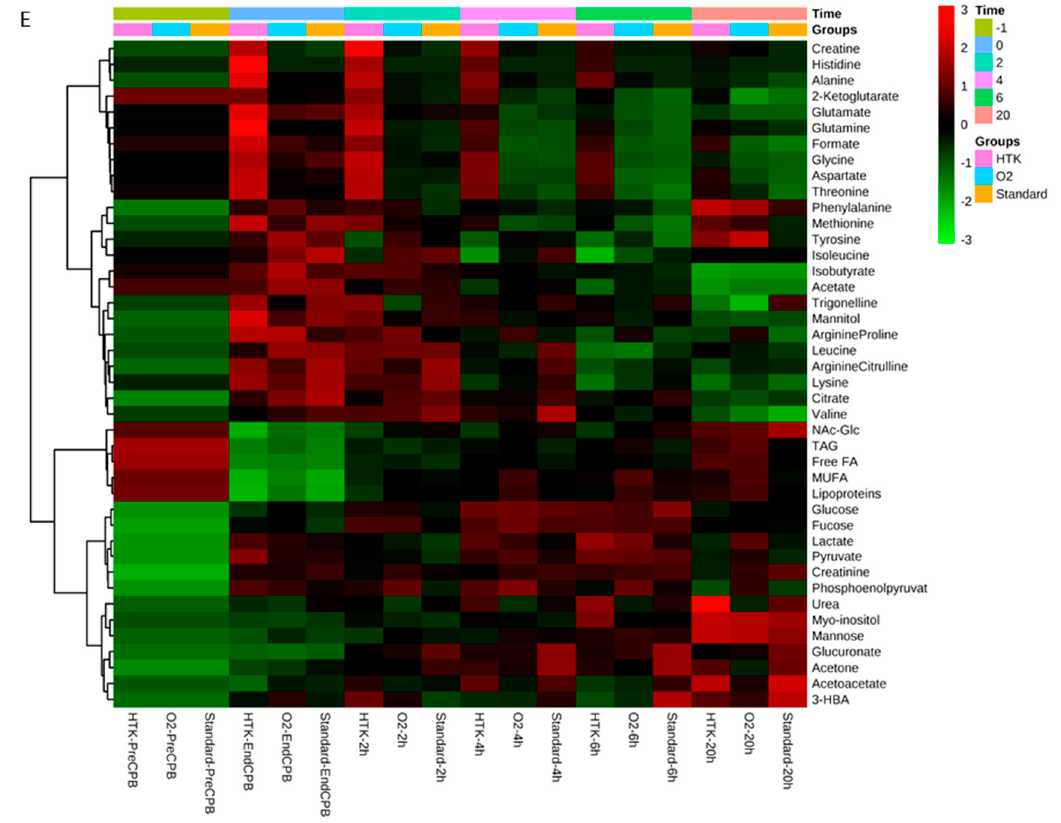
Figure 3. Metabolome changes as a consequence of the surgical procedure and lung protection regimen received. ( A ) Principal component analysis (PCA) scores plot containing NMR spectral data of plasma collected before CPB (blue), at the end of CPB (cyan), 2 h (green), 4 h (brown), 6 h (orange), and 20 h post-CPB (yellow). Samples cluster according to the time of sample collection. ( B ) Same PCA scores plot as in (A) but samples are color coded according to intervention group: standard CPB with no pulmonary perfusion (black), pulmonary artery perfusion with hypothermic histidine-tryptophan-ketoglutarate (HTK) (blue), pulmonary artery perfusion with normothermic oxygenated blood (O 2 blood) (red). CL, confidence level; PC, principal component 1 and 2. ( C ) Correlation of metabolites concentrations measured at the end of CPB with CPB duration; lactate, pyruvate, and citrate levels increased (+), while monounsaturated fatty acids (MUFA) and lipoprotein levels decreased ( − , with a longer duration of CPB. ( D ) Pie plot representation of metabolites demonstrated significant changes over time as a consequence of CPB (purple) and treatment allocation (white) explored by means of two-way ANOVA. ( E ) Heat map representation of mean percent changes of metabolites in relation to pre-operative values. Mean percent changes were calculated using the formula (postCPB − preCPB)/preCPB · 100. Green: lower concentration; red: higher concentration. 3-HBA, 3-hydroxybutyric acid; NAc-Glc, N-acetylated glycoprotein fragment; TAG, triacylglycerol; FA, fatty acid; MUFA, monounsaturated fatty acid.